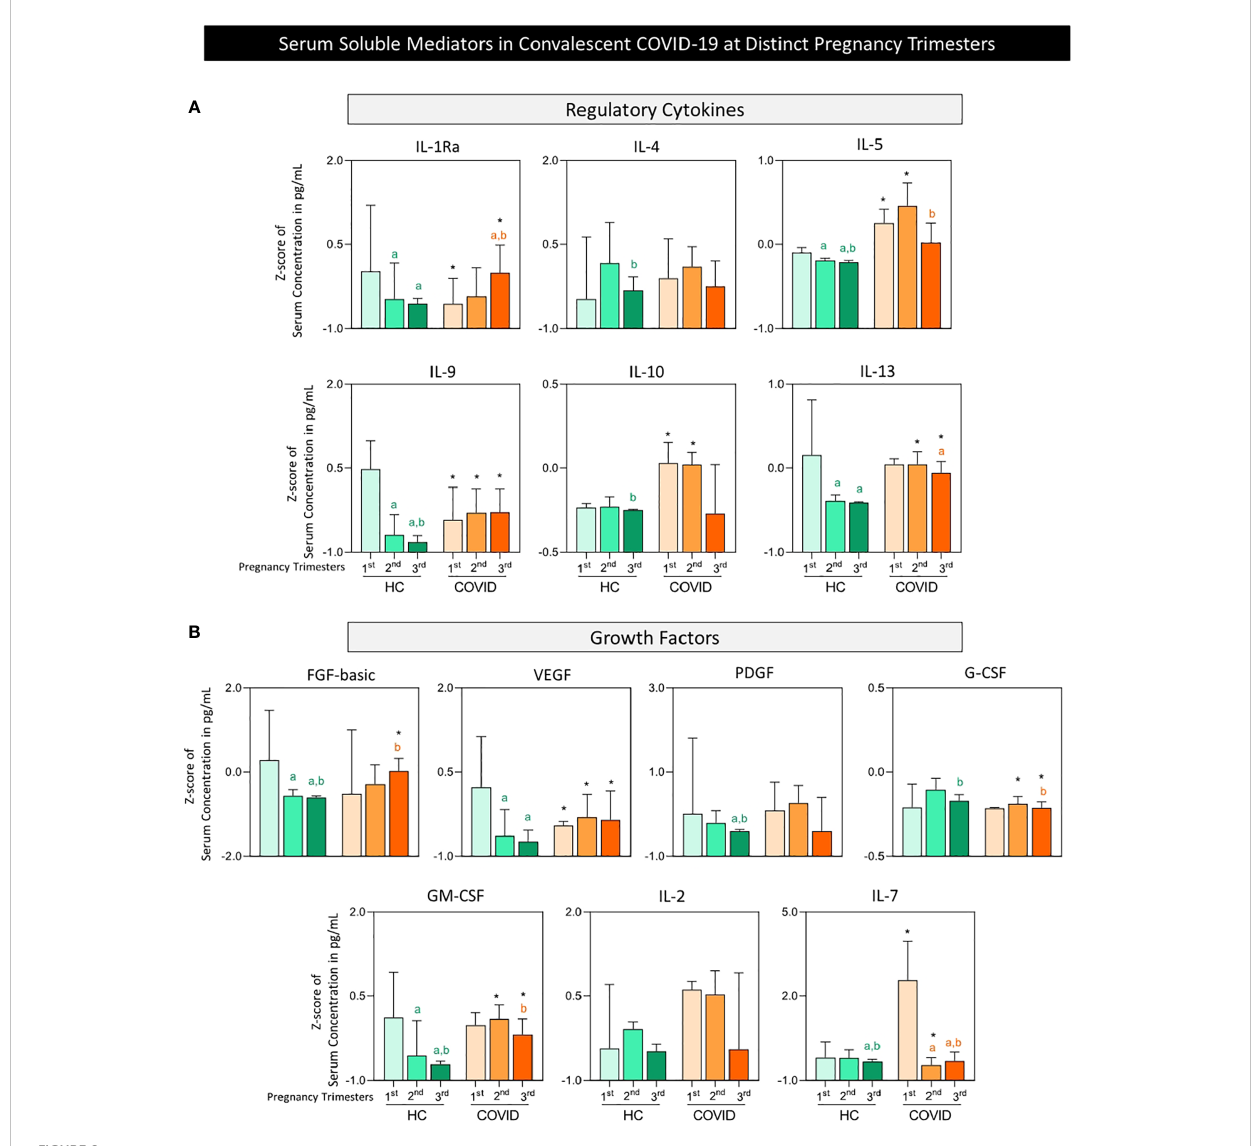
FIGURE 2 Serum regulatory cytokines and growth factors in convalescent COVID-19 patients at distinct pregnancy trimesters. The levels of: (A) regulatory cytokines (IL-1Ra, IL- 4, IL-5, IL-9, IL-10, IL-13), and (B) growth factors (FGF-basic, PDGF, VEGF, G-CSF, GM- CSF, IL-2, IL-7) were measured in serum samples from pregnant women with convalescent COVID-19 at 3-20 weeks after symptoms onset (COVID, n=89), with pre-pandemic non- infected pregnant women as a Healthy Control (HC, n=52). The HC and COVID-19 groups were further categorized into subgroups according to pregnancy trimester, referred to as: HC 1 st ( , n=48). The measurements were taken by high-throughput multiplex bead array as described in Material and Methods. The results are presented in bar charts of median values and interquartile ranges for Z-score of serum concentration (pg/mL). Multiple comparative analysis was performed by Kruskal-Wallis followed by Dunn ’ s post-test, and comparisons between COVID-19 and HC at matching pregnancy trimesters assessed by the Mann-Whitney test. In all cases, signi fi cance was considered at p<0.05. Intragroup differences were underscored by the letters “ a ” and “ b ” for comparisons with the 1 st and 2 nd trimesters, respectively. Inter-group differences at matching pregnancy trimesters were denoted by an asterisk